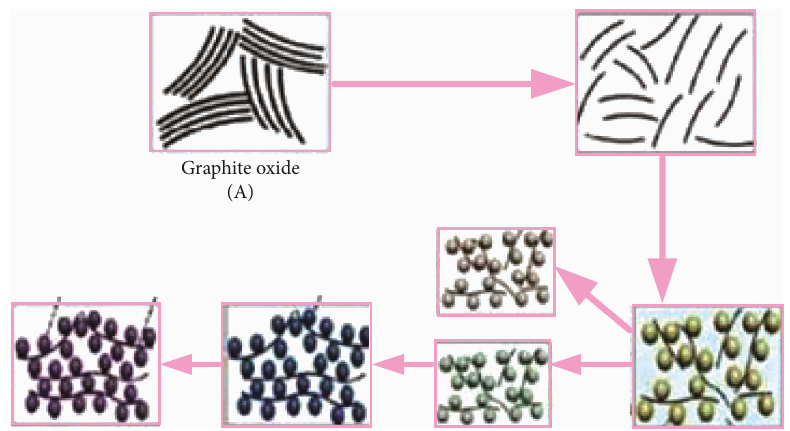
Figure 1: Graphene